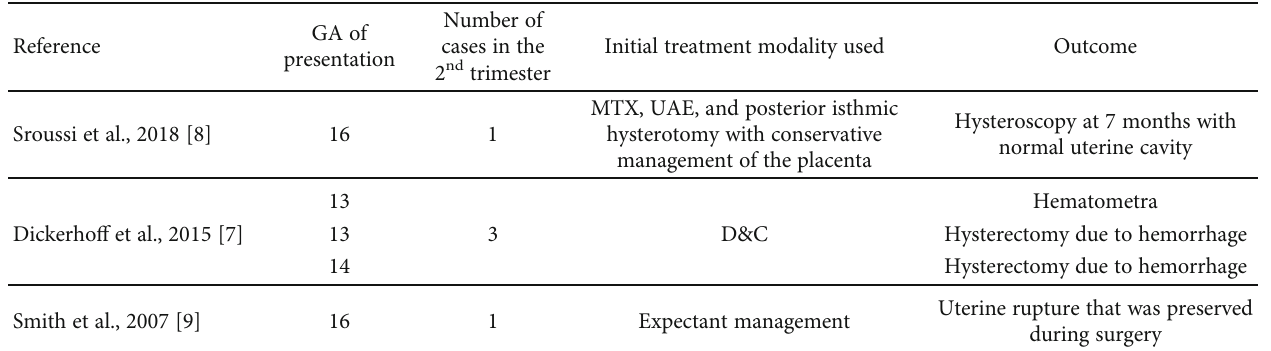
Table 1: Review of the literature for second trimester ectopic